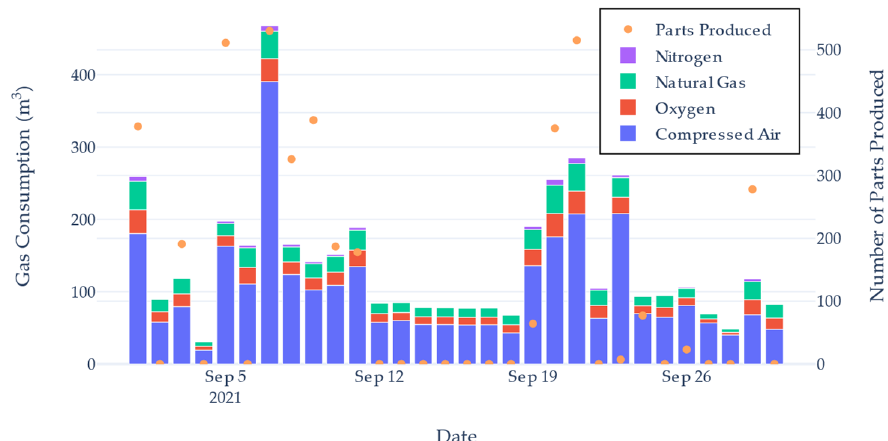
Figure 8. Gas Consumption Total and Part Production Total plot.